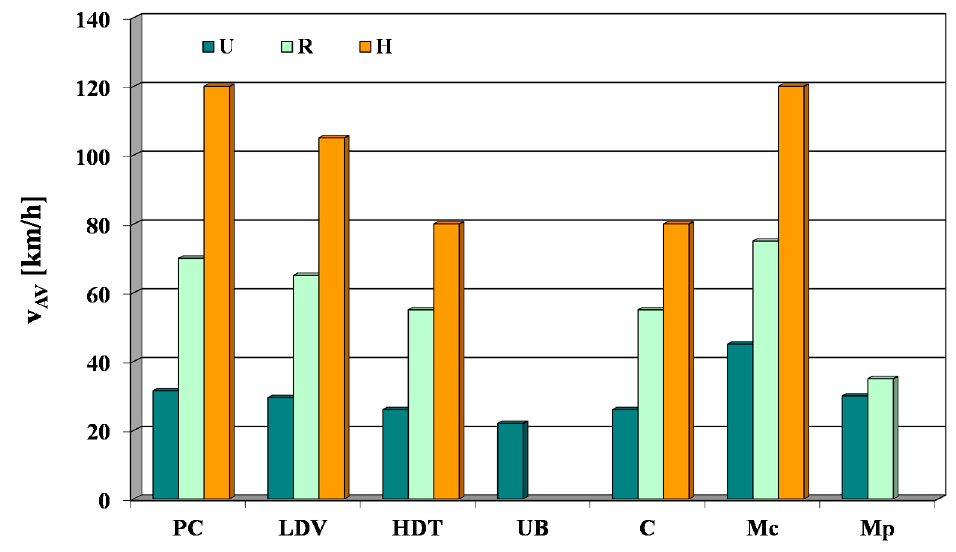
Figure 4. Average velocity (v AV ) of passenger cars (PC), light duty vehicles (LDV), heavy duty vehicles (HDT), urban buses (UB), coaches (C), motorcycles and quads (Mc) and mopeds (Mp) under different traffic conditions: urban (U), rural (R) and highway (H).